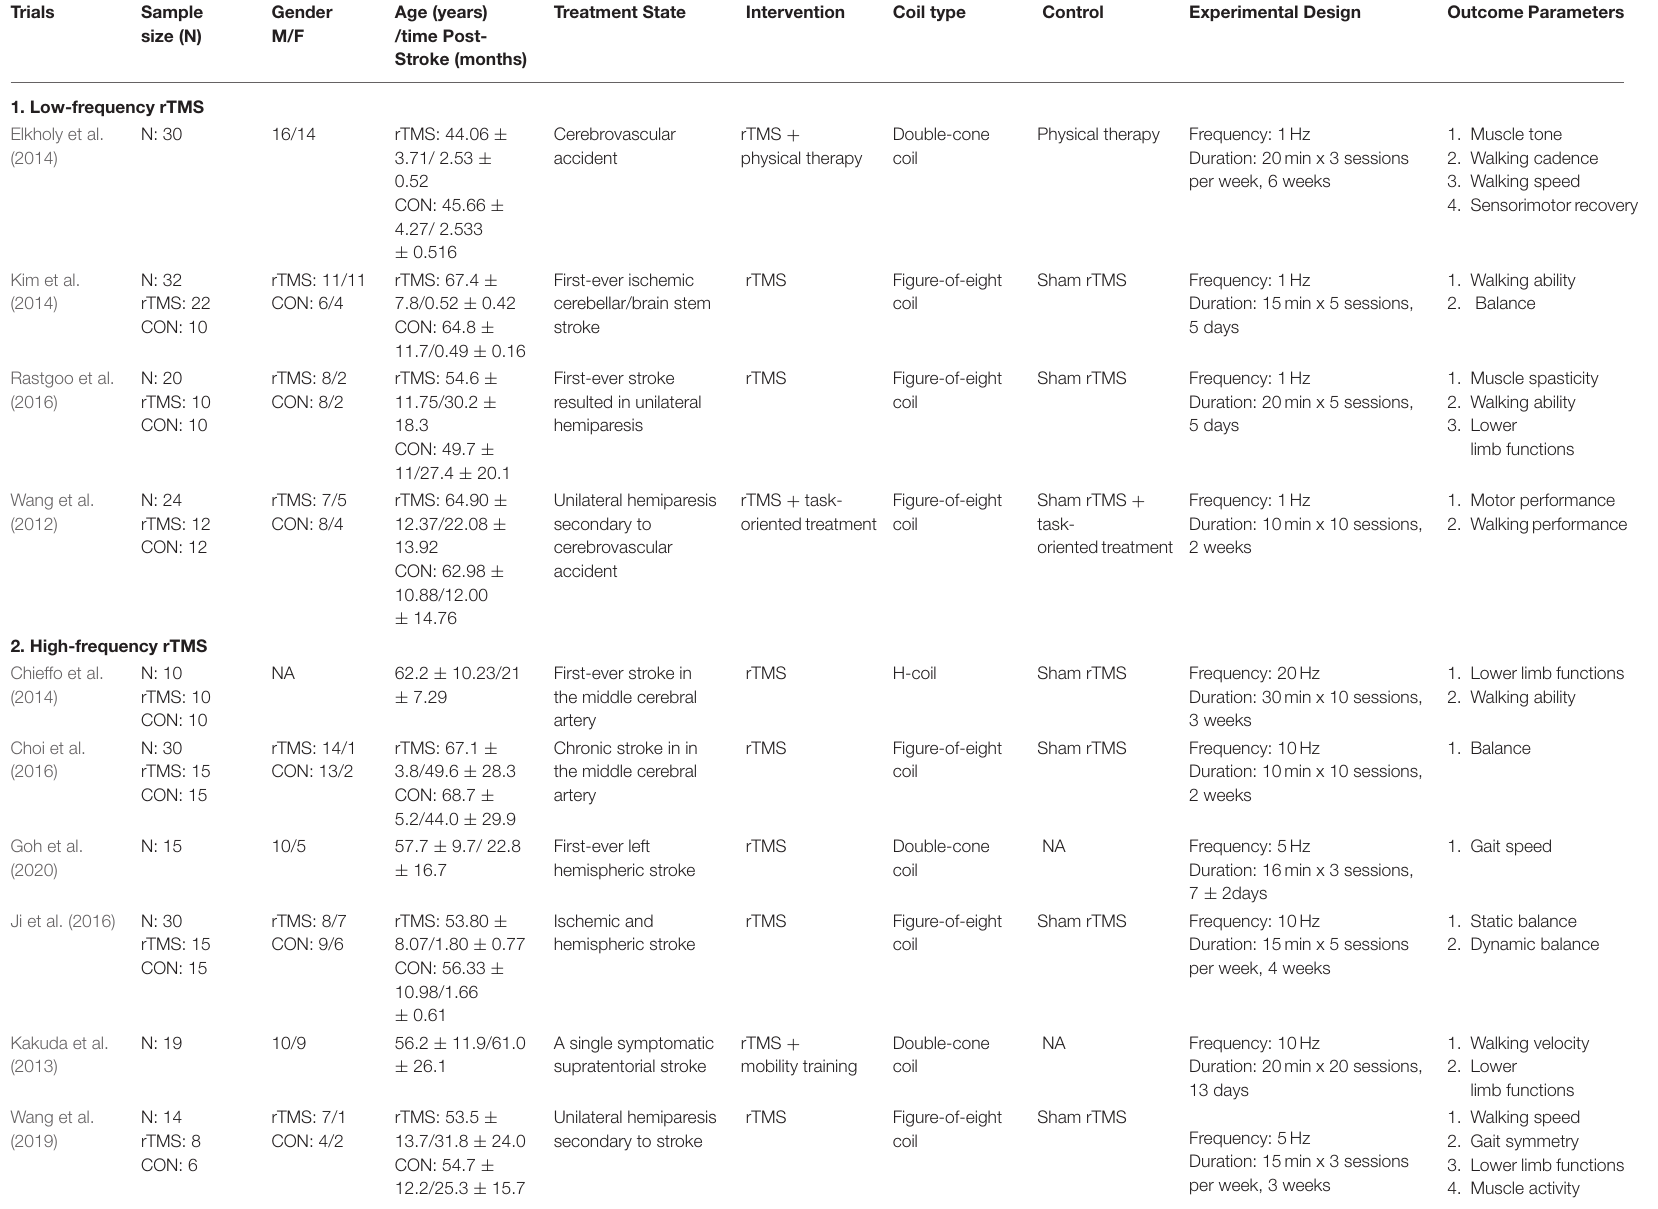
TABLE 2 | The basic characteristics of the included studies.